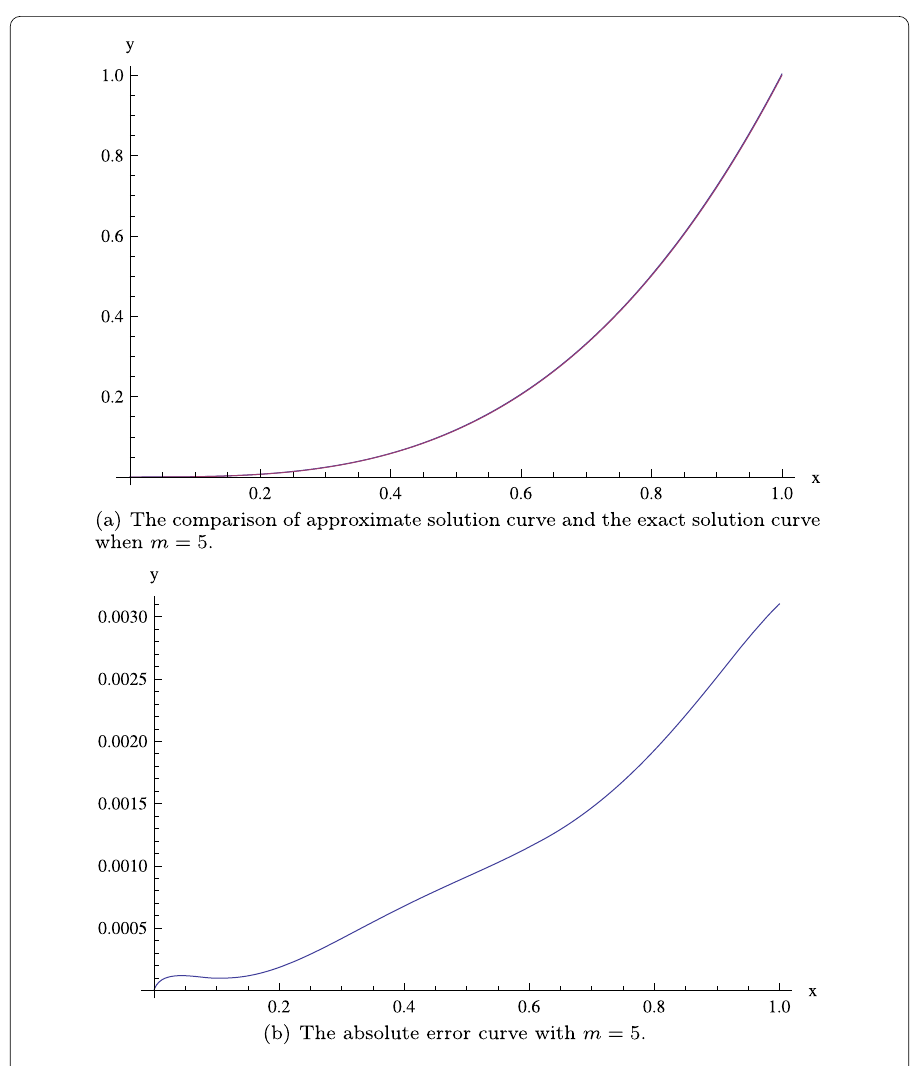
Figure 5 The comparison of the approximate solution and the exact solution when m =